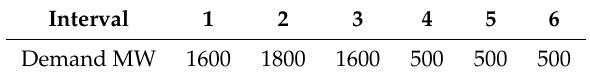
Table 1. Load demand for each scheduling interval of four hours each.